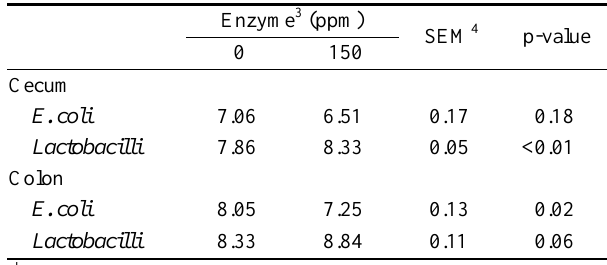
Table 5. Effect of enzyme supplementation on large intestinal microbiota in the cecum and colon of weaned pigs 1, 2